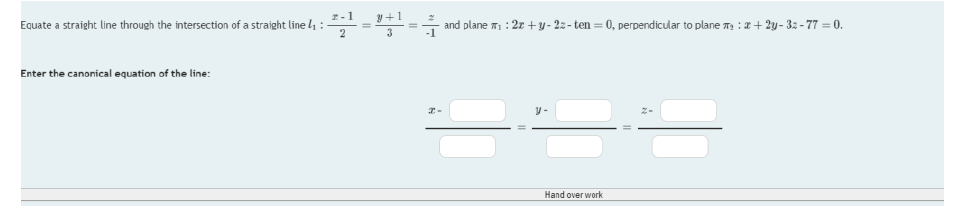
Fig. 2. The problem of finding the equation of a straight